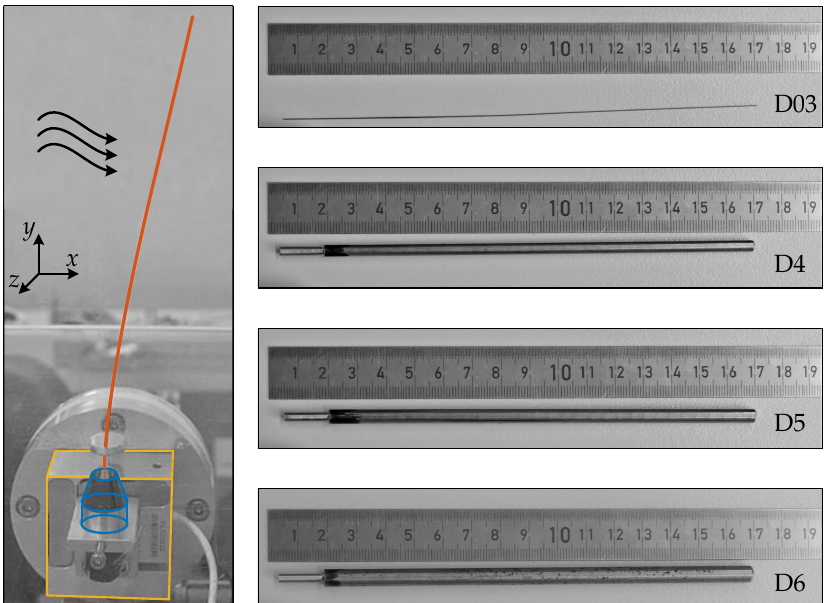
Figure 4. In the left picture, the sensor shaft D03 (orange) is clamped by a miniature jaw chuck (blue) and mounted onto the force sensor (yellow) while it stays inside a flow (black arrows). On the right